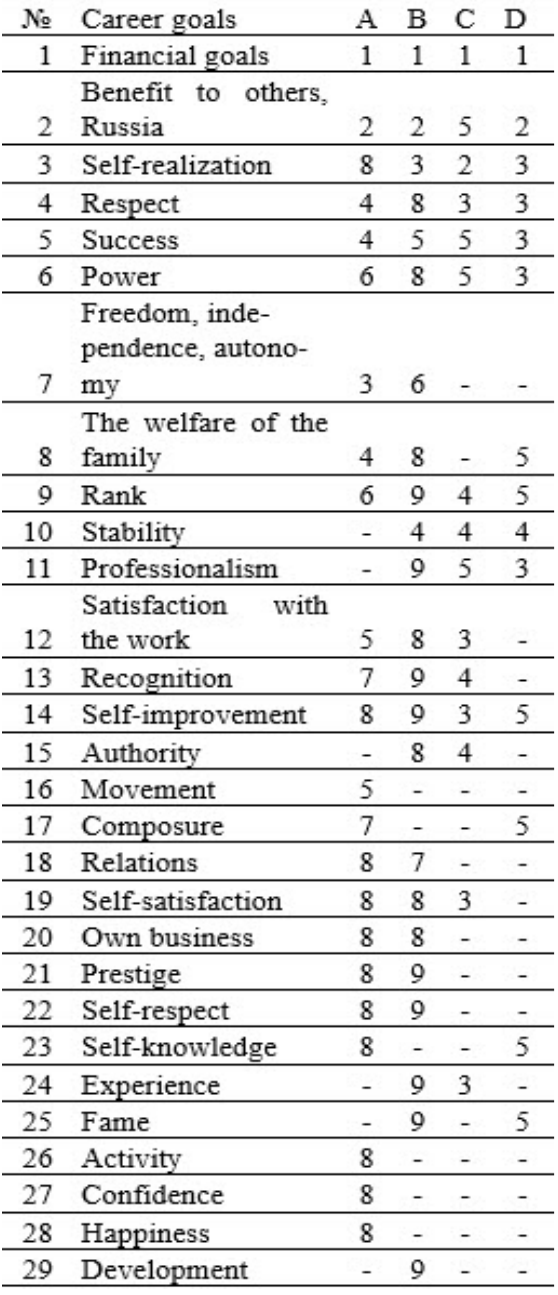
Table 3. The peculiarities of career